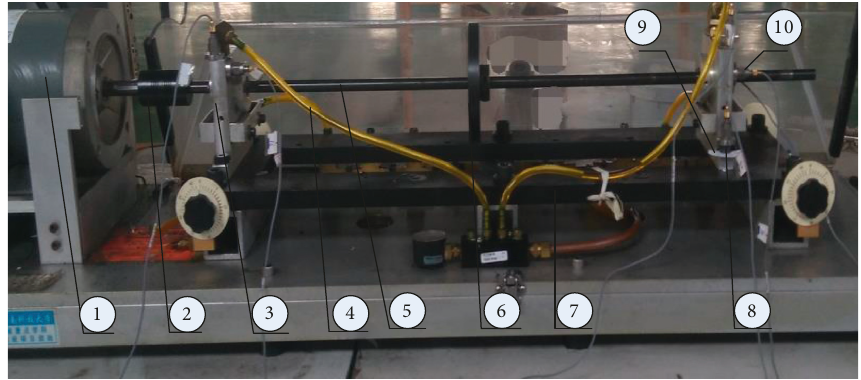
Figure 15: Experiment